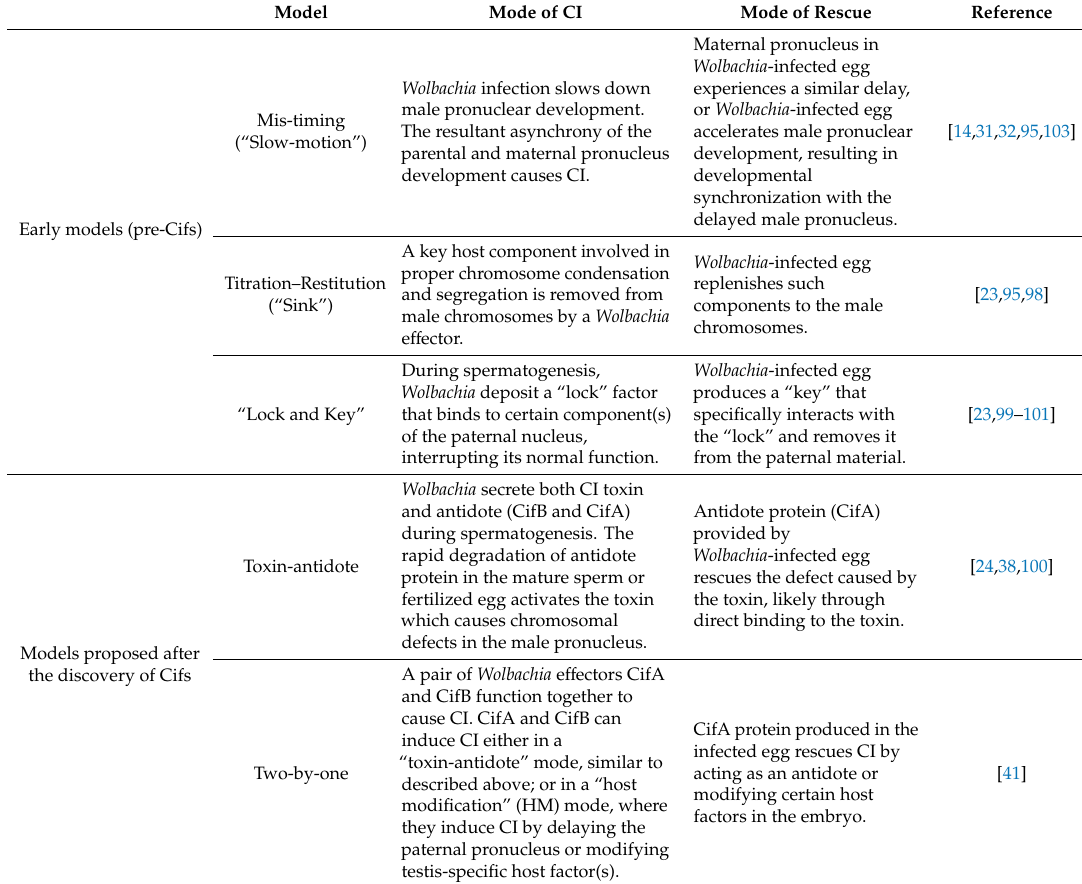
Table 1. Summary of proposed models for cytoplasmic incompatibility and